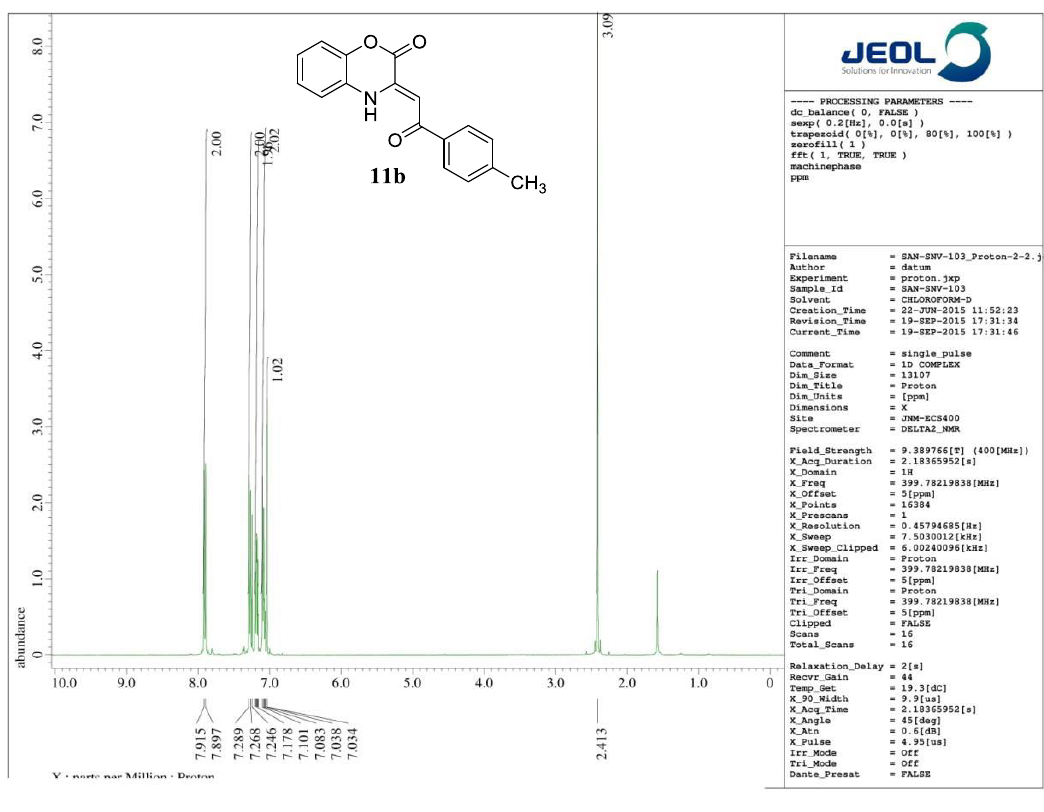
Figure 3. 1 H NMR Spectra of Compound 11b .